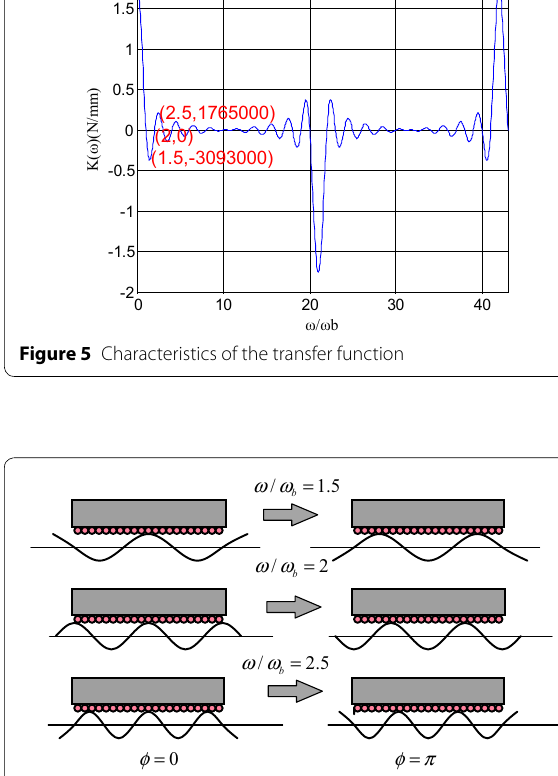
Figure 3 Phase relationship between the rolling guideway straightness errors and the carriage bearing forces